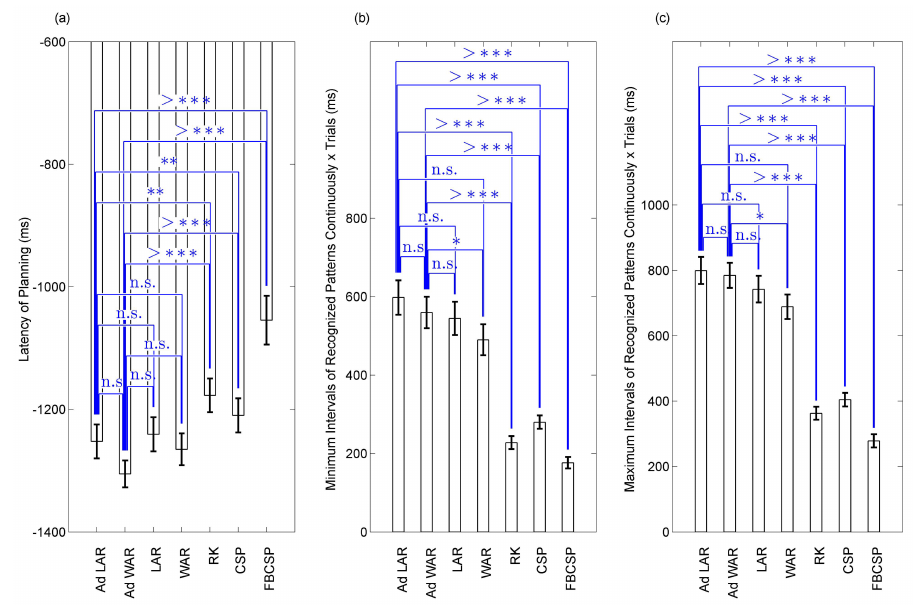
Figure 7. Performance in the time domain of the BCI during gait planning recognition,